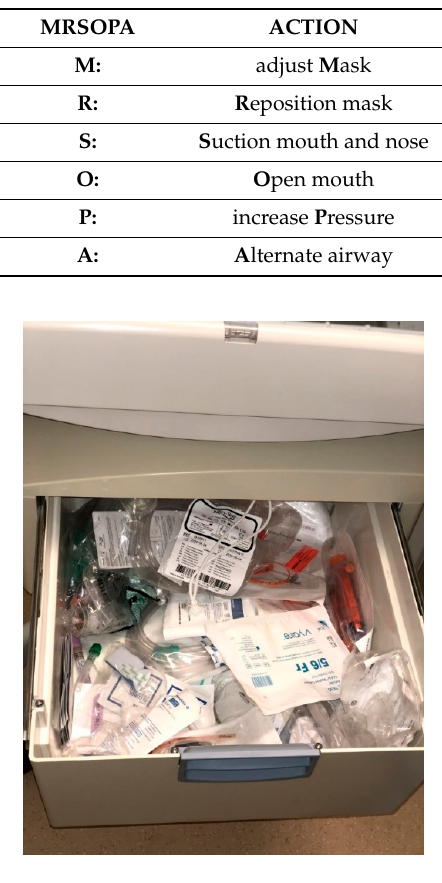
Figure 3. Mother–Baby Radiant Warmer Drawer Before Simulation.